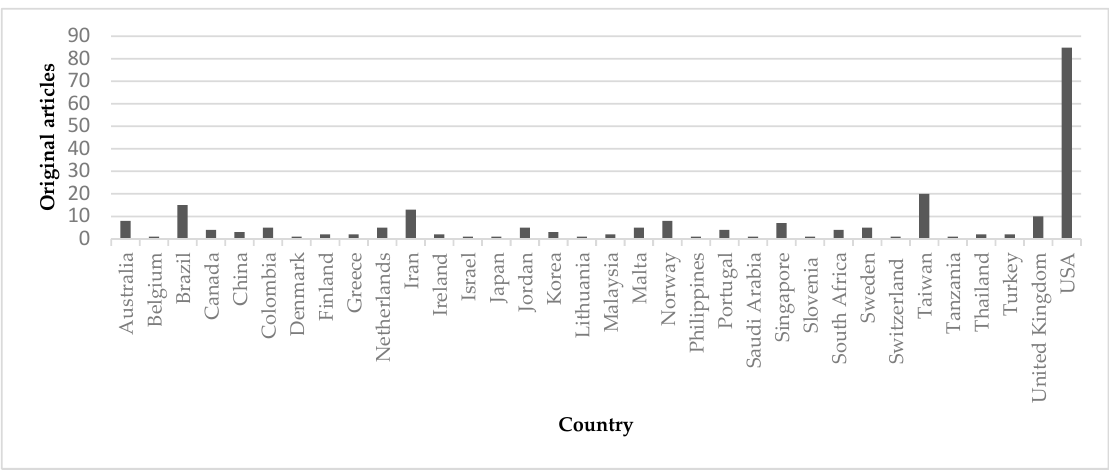
Table 2. Categories of the results in this review.